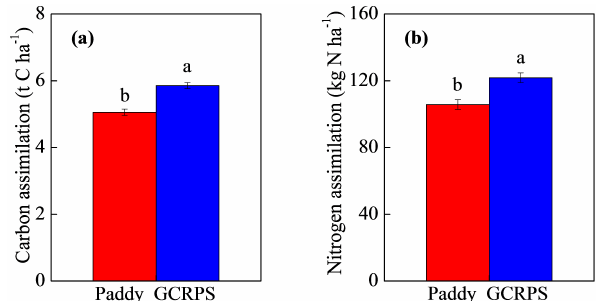
Figure 3. Carbon and nitrogen assimilated in aboveground biomass at maturity ( n is 108). Data presented are the means pooled over 36 paired sites (these represent all the sites where rice was grown in 2011) with three replicates at each site. Errors bars indicate SEM. Bars labeled with different lowercase letters indicate statistically significant differences ( P <0.05) between paddy sites and